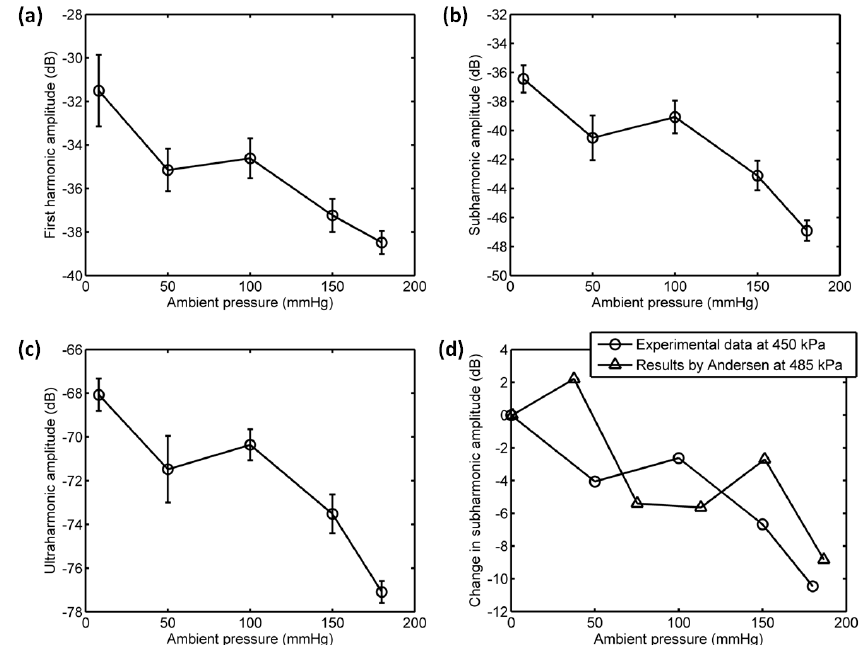
Figure 13. The relationships between the frequency components of the microbubbles’ scattered signals and the overpressure. ( a ) The first harmonic amplitude vs. ambient pressure, ( b ) the subharmonic amplitude vs. ambient pressure, ( c ) the ultraharmonic amplitude vs. ambient pressure, and ( d ) the comparison between the measurement in this study and the reported experimental results. The driving frequency was 4 MHz, the acoustic pressure was 450 kPa. The transmitted tone burst with 64 cycles had a PRF of 1 kHz.